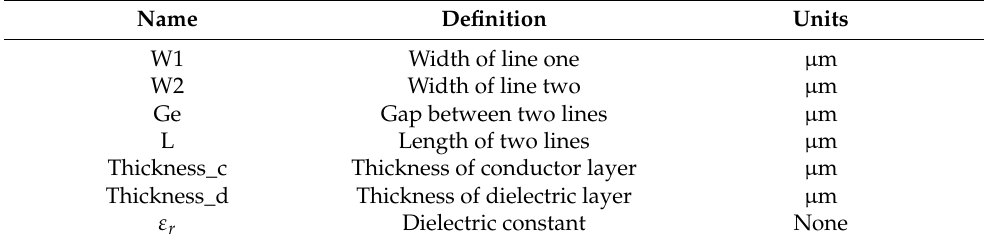
Figure 10. The layout of coupled transmission lines. Table 12. Parameter of coupled transmission